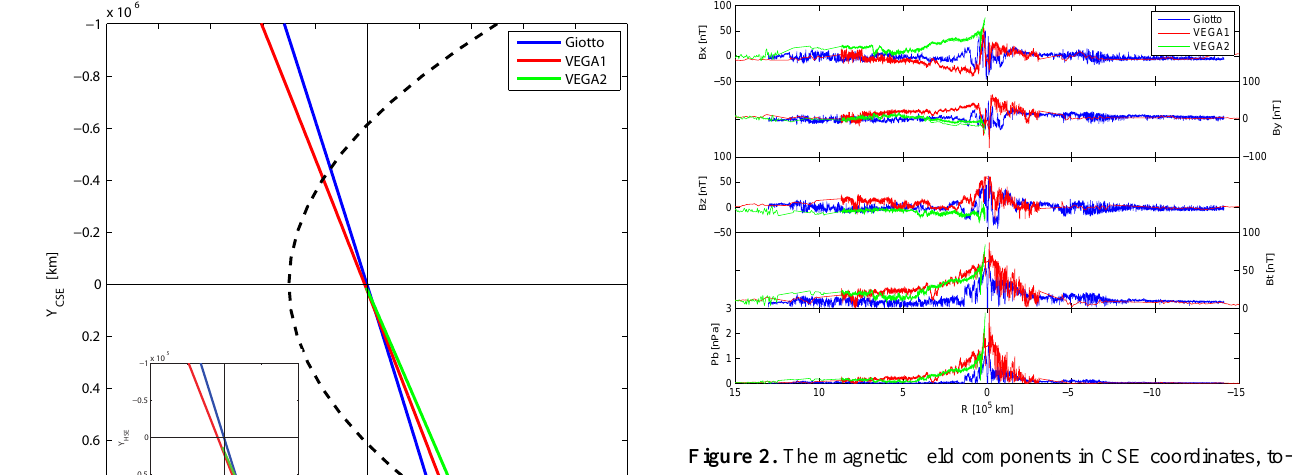
Figure 2. The magnetic field components in CSE coordinates, to- tal field B t and magnetic pressure P b of the three flybys by Giotto (blue), VEGA 1 (red) and VEGA 2 (green).